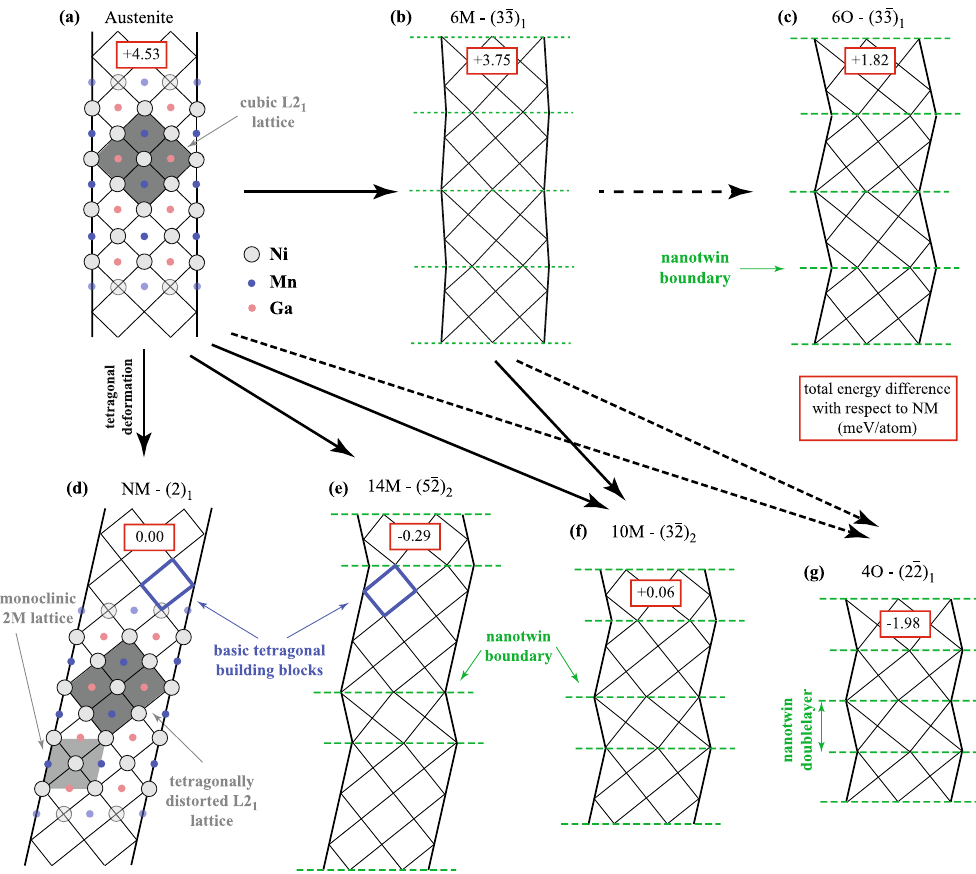
Figure 1. Schematic illustration of the austenite A ( a ), premartensite 6M ( b ) and martensite structures: 6O ( c ), NM ( d ), 14M ( e ), 10M ( f ) and 4O ( g ) in Ni-Mn-Ga system (6O is present for the purpose of comparison, it has not been reported for Ni-Mn-Ga). Gray filling in A and NM identify the original and tetragonally distorted L2 1 cell and monoclinic 2M cell, respectively; basic tetragonal building blocks are marked with blue in ( d ) and ( e ); the green dashed lines mark nanotwin boundaries; numbers in red boxes correspond to total energy differences in meV/atom relatively to NM